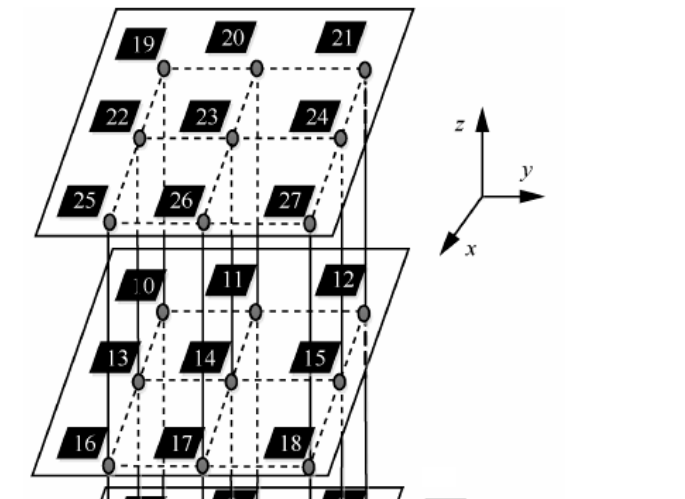
Figure 1. Architecture Characteristic Graph.